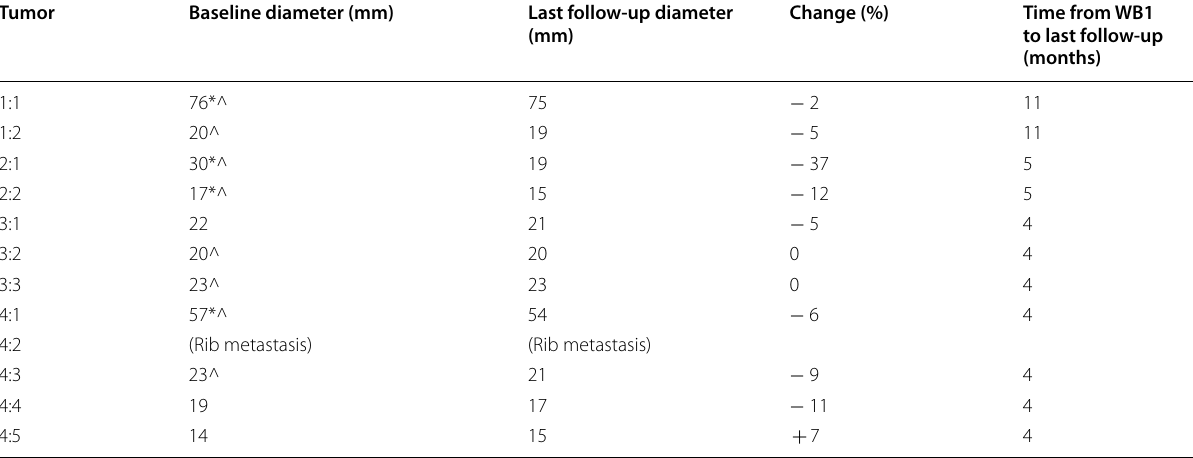
*Tumors with patchy areas of necroses ^Tumors selected for the separate analyses of the two largest tumors per patient (Please see Additional file 3: Figure S3, Additional file 4: Figure S4 and Additional file 6: Figure S6)